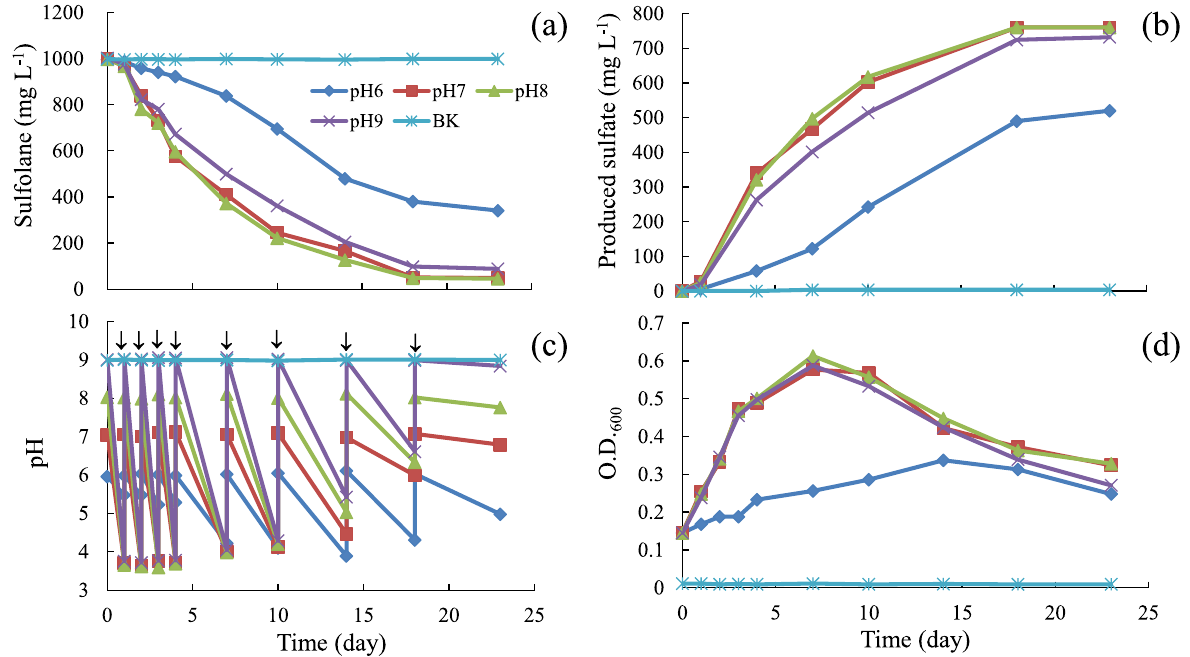
Fig. 2 Sulfolane ( a ), sulfate ( b ), pH ( c ) and O.D. 600 ( d ) variations during 1000 mg L − 1 sulfolane biodegradation by strain Cupriavidus sp. Y‑d at various initial pHs. Arrow indicates pH adjustment. BK refers to no added